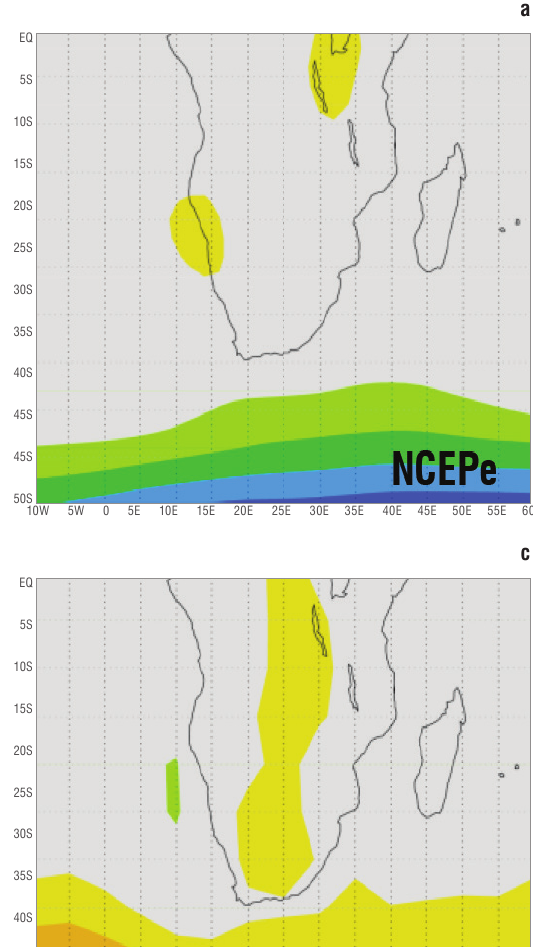
3 Volume 109 | Number 9/10